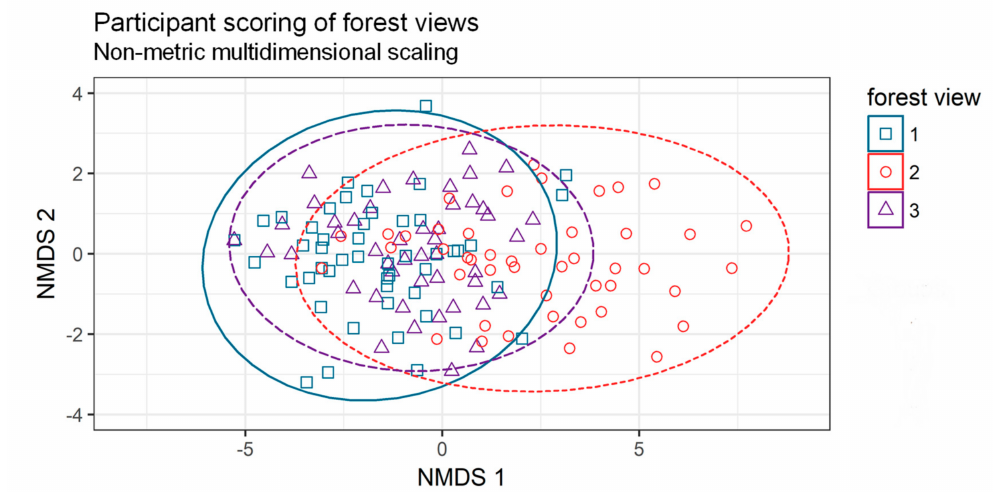
Figure 3. Results of ordination statistics to differentiate between the evaluations of fv1, fv2 and fv3. The axes describe the non-metric distances between the objects (forest views). The distances reveal which objects are similar to one another.